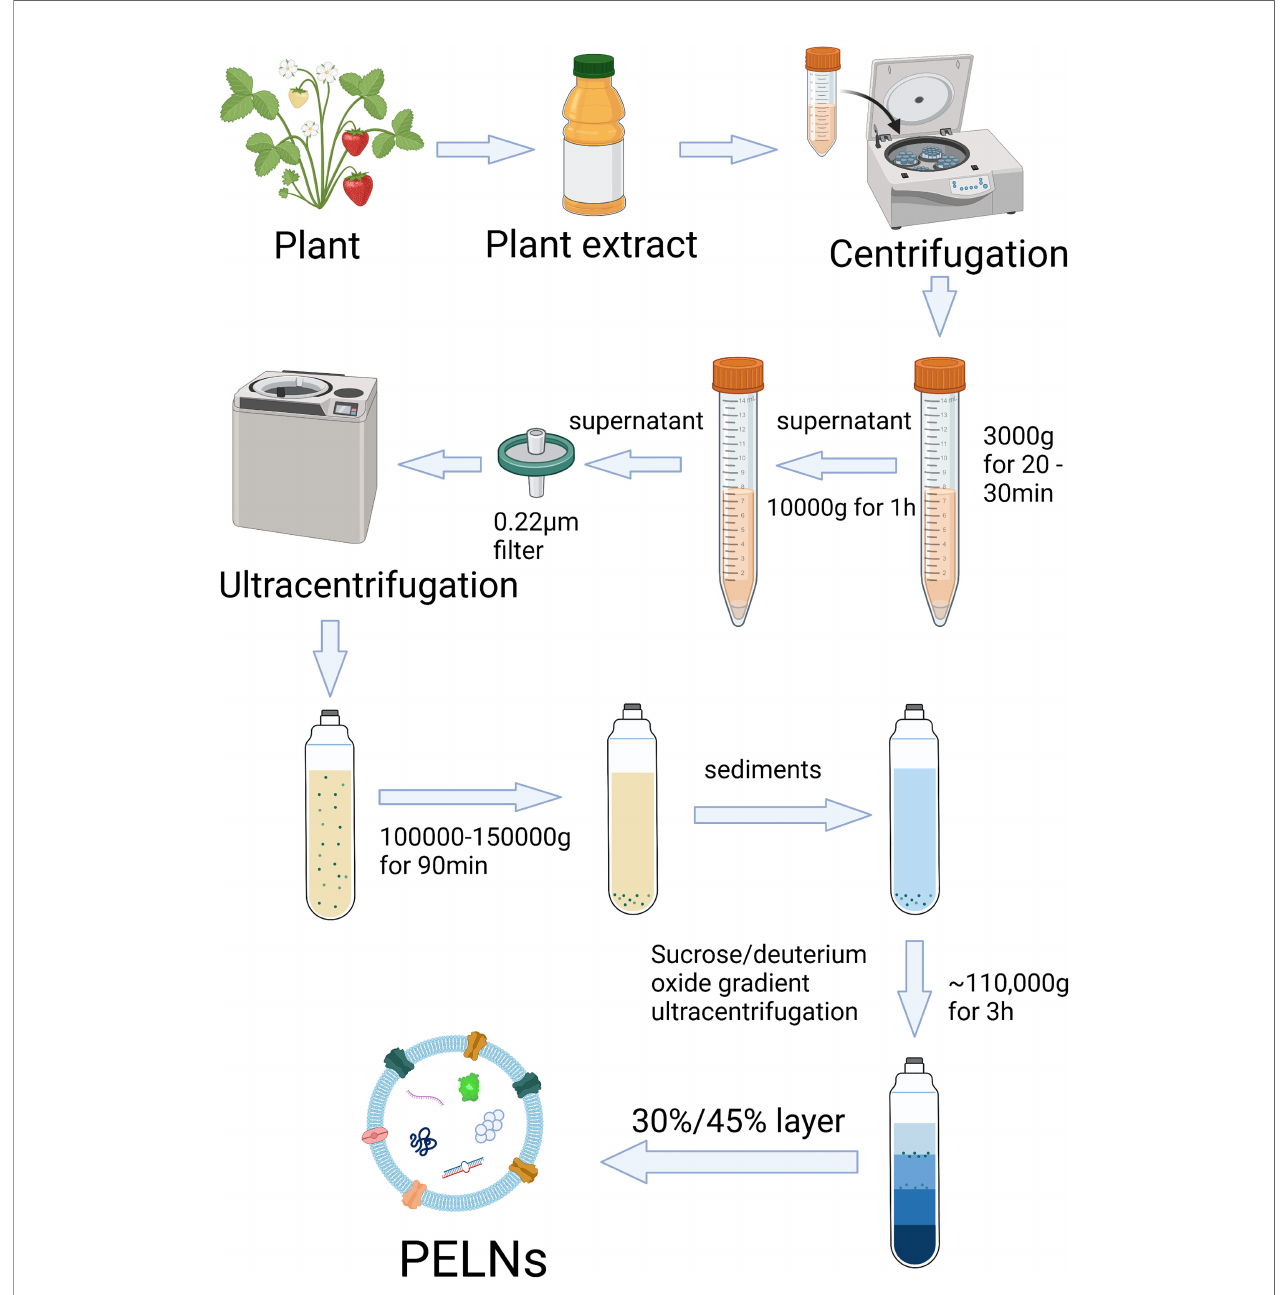
FIGURE 2 | Scheme of isolation and puri fi cation of PELNs by differential ultracentrifugation and sucrose gradient ultracentrifugation. Created with